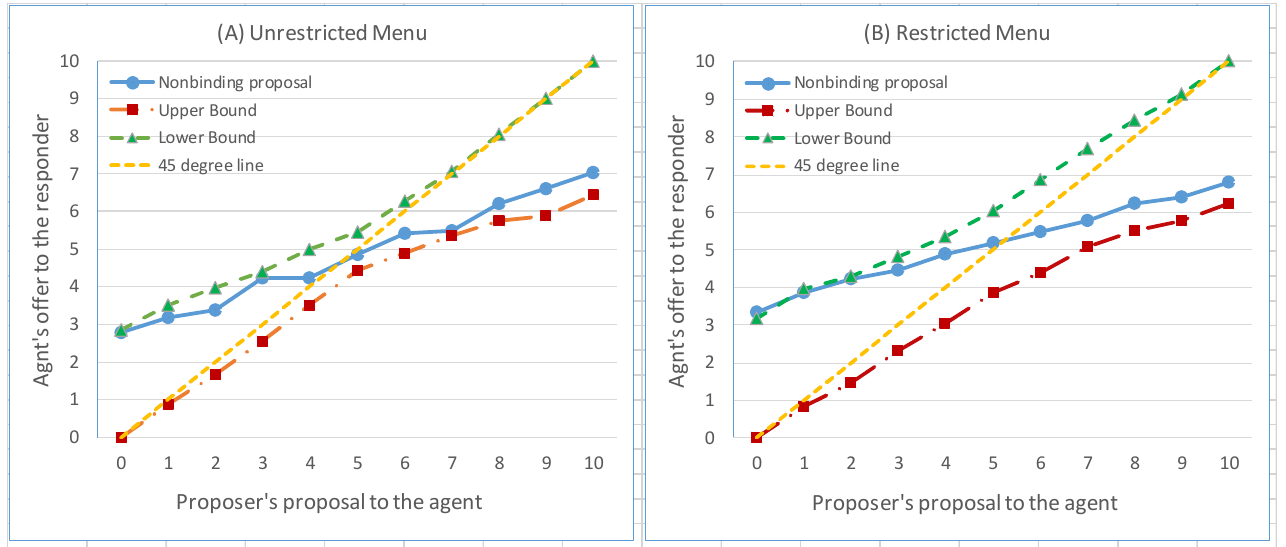
Table 5. Estimates for linear regression of agent’s response function for each of the settings (non- binding proposal setting, Upper Bound, and Lower Bound) as well as pooled settings. Right and left censoring was conducted via Tobit in the Upper Bound setting and Lower Bound setting, re- spectively, and two-sided censoring was performed in the pooled regression. Robust standard er- rors (N = 40) are reported in all cases. There are 40 participants per cell, and 320 participants in total. Parameter Unrestricted Menu Restricted Menu Setting 1 ‘Nonbinding Proposal’ (440 observations, 40 clusters) Intercept 2.703 * (0.484) 3.476 * (0.441) Proposal 0.430 * (0.073) 0.334 * (0.058) LL −1021.193 −985.71129 Setting 2 ‘Upper Bound’ (440 observations, 40